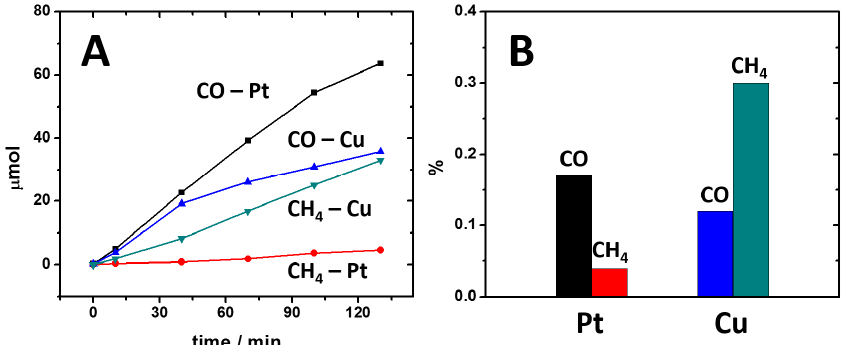
Figure 3. ( A ): Evolution curves for the two major products (CO and CH 4 ) from the electrochemical reduction of gaseous CO 2 with the Pt/CsH 2 PO 4 /Cu and Pt/CsH 2 PO 4 /Pt MEAs (surface area: 1 cm 2 , thickness: 0.06 mm); ( B ): Comparison diagram (Faradaic efficiency) for the two major products (CO and CH 4 ) from the electrochemical reduction of gaseous CO 2 with the Pt/CsH 2 PO 4 /Cu and Pt/CsH 2 PO 4 /Pt MEAs (H 2 /CO 2 (0.4 atm H 2 O for both), 250 °C).